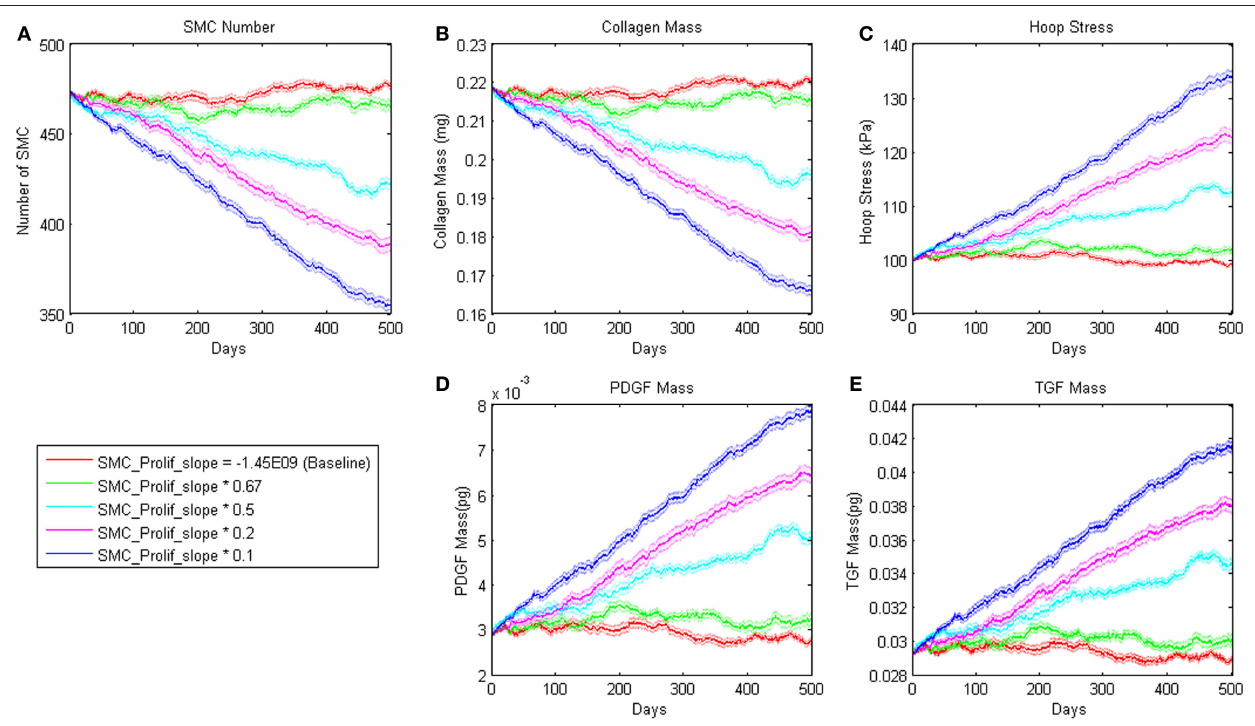
Figure 3 | Sensitivity of ABM outputs to changes in proliferation rate of SMc in response to PDgF-AB. Note that for smaller changes in this parameter, SMC number and collagen mass reach a new equilibrium as hoop stress increases enough to support PDGF-AB and TGF- β production and therefore cell proliferation and